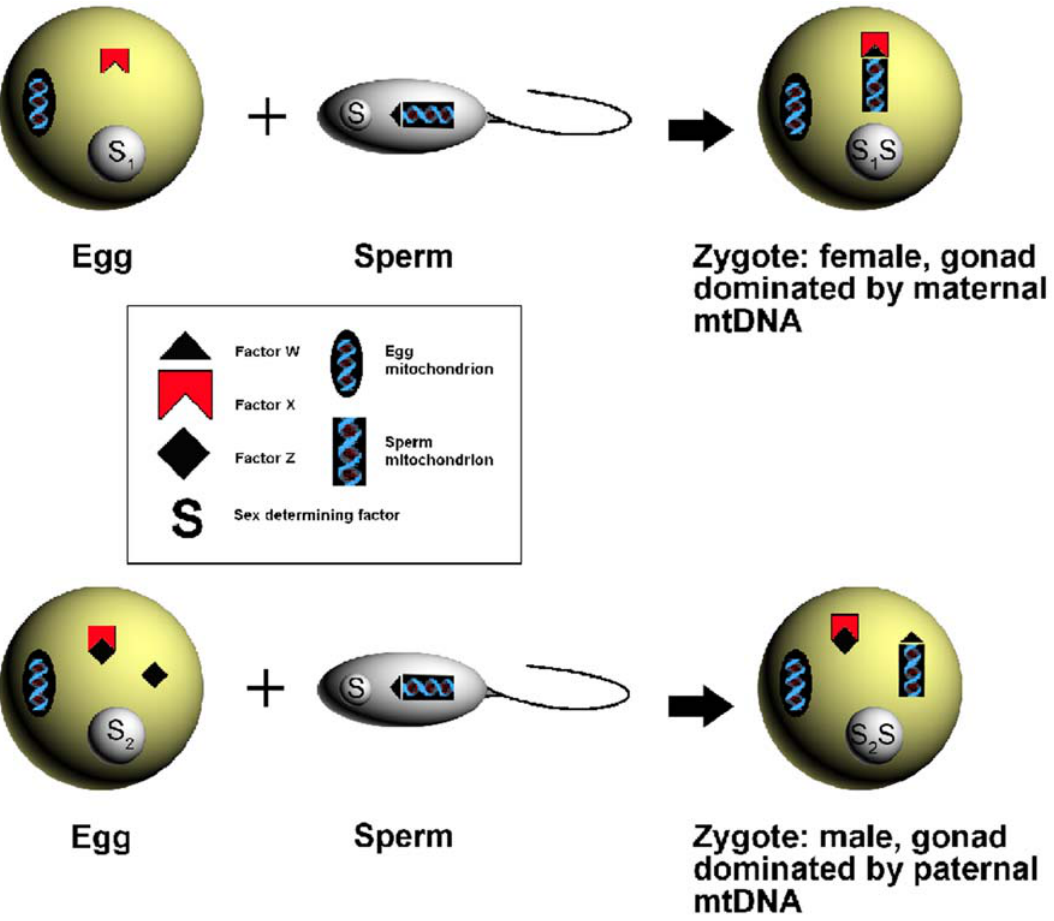
Figure 5. A model for sex determination and paternal mtDNA inheritance in mussels. Sex is determined by a nuclear locus S, with two alleles, S 1 and S 2 , with different ‘‘dosage’’ effect (S 1 =1, S 2 =2). For maleness it is required that the dosage is 2 or higher. Only the maternal allele is expressed during the development of sex. The paternal allele is masked and contributes a dosage of zero, regardless of whether it is S 1 or S 2 . Thus, sex is determined by the mother’s genotype. The genotype of the male parent affects the sex of the progeny of his daughters. Paternal mtDNA transmission is affected by three nuclear genes. Locus W is male-expressed. It’s product labels the outer surface of sperm mitochondria and differentiates them from egg mitochondria. Locus X is female-expressed. It supplies the egg with a factor that interacts with W and prevents sperm mitochondria from aggregating and co-segregating into the first germ cells. Locus Z is also female-expressed. It segregates for an active (Z) and an inactive (z) allele. It supplies the eggs with factor Z which suppresses factor X and allows sperm mitochondria to aggregate and co-segregate into the first germ cells. There is a tight linkage between Z and S 2 and between z and S 1 so that only the combinations ZS 2 and zS 1 may occur in an egg. Sperm mitochondria occur in the sperm’s mid-piece, but are shown in the ‘‘head’’ for convenience. Egg mitochondria far out-number sperm mitochondria but we show one of each kind for